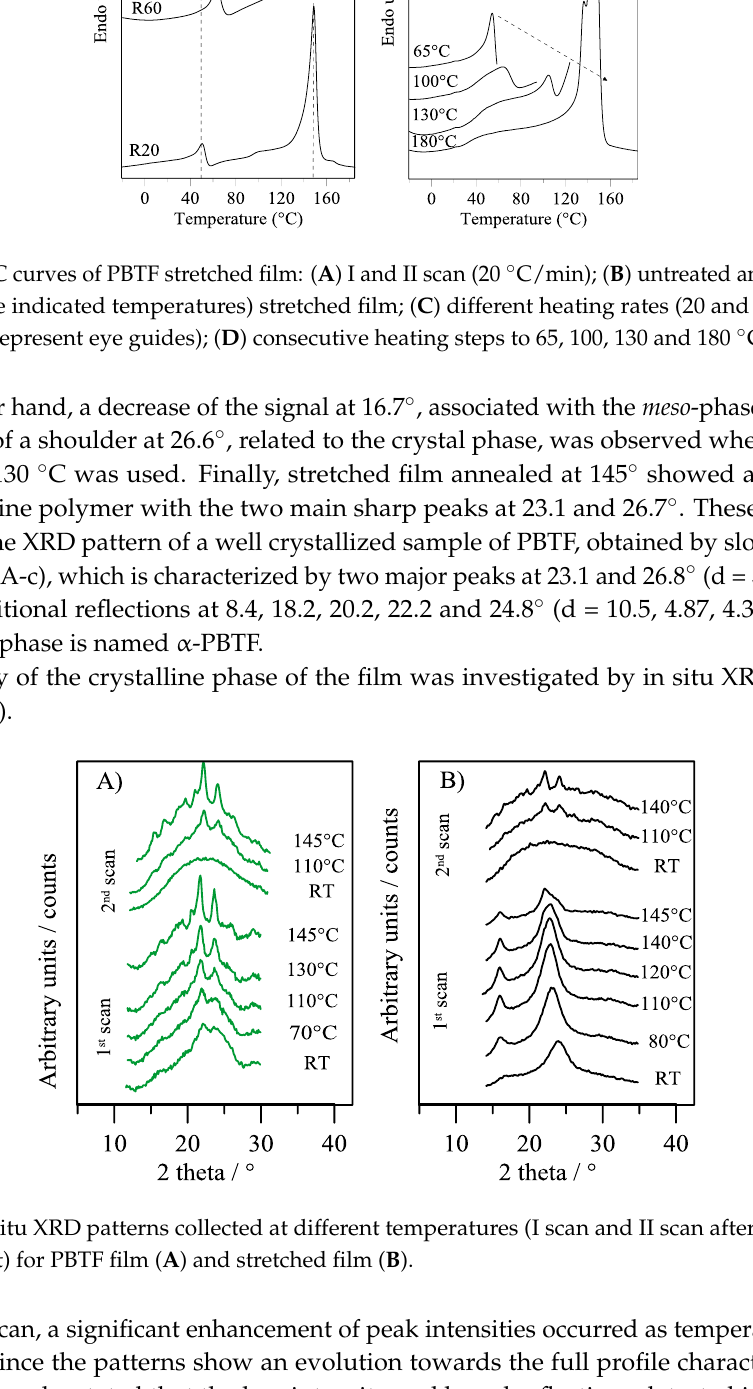
Figure 4. In situ XRD patterns collected at different temperatures (I scan and II scan after quenching from the melt) for PBTF film ( A ) and stretched film ( B ). from the melt) for PBTF film ( A ) and stretched film ( B